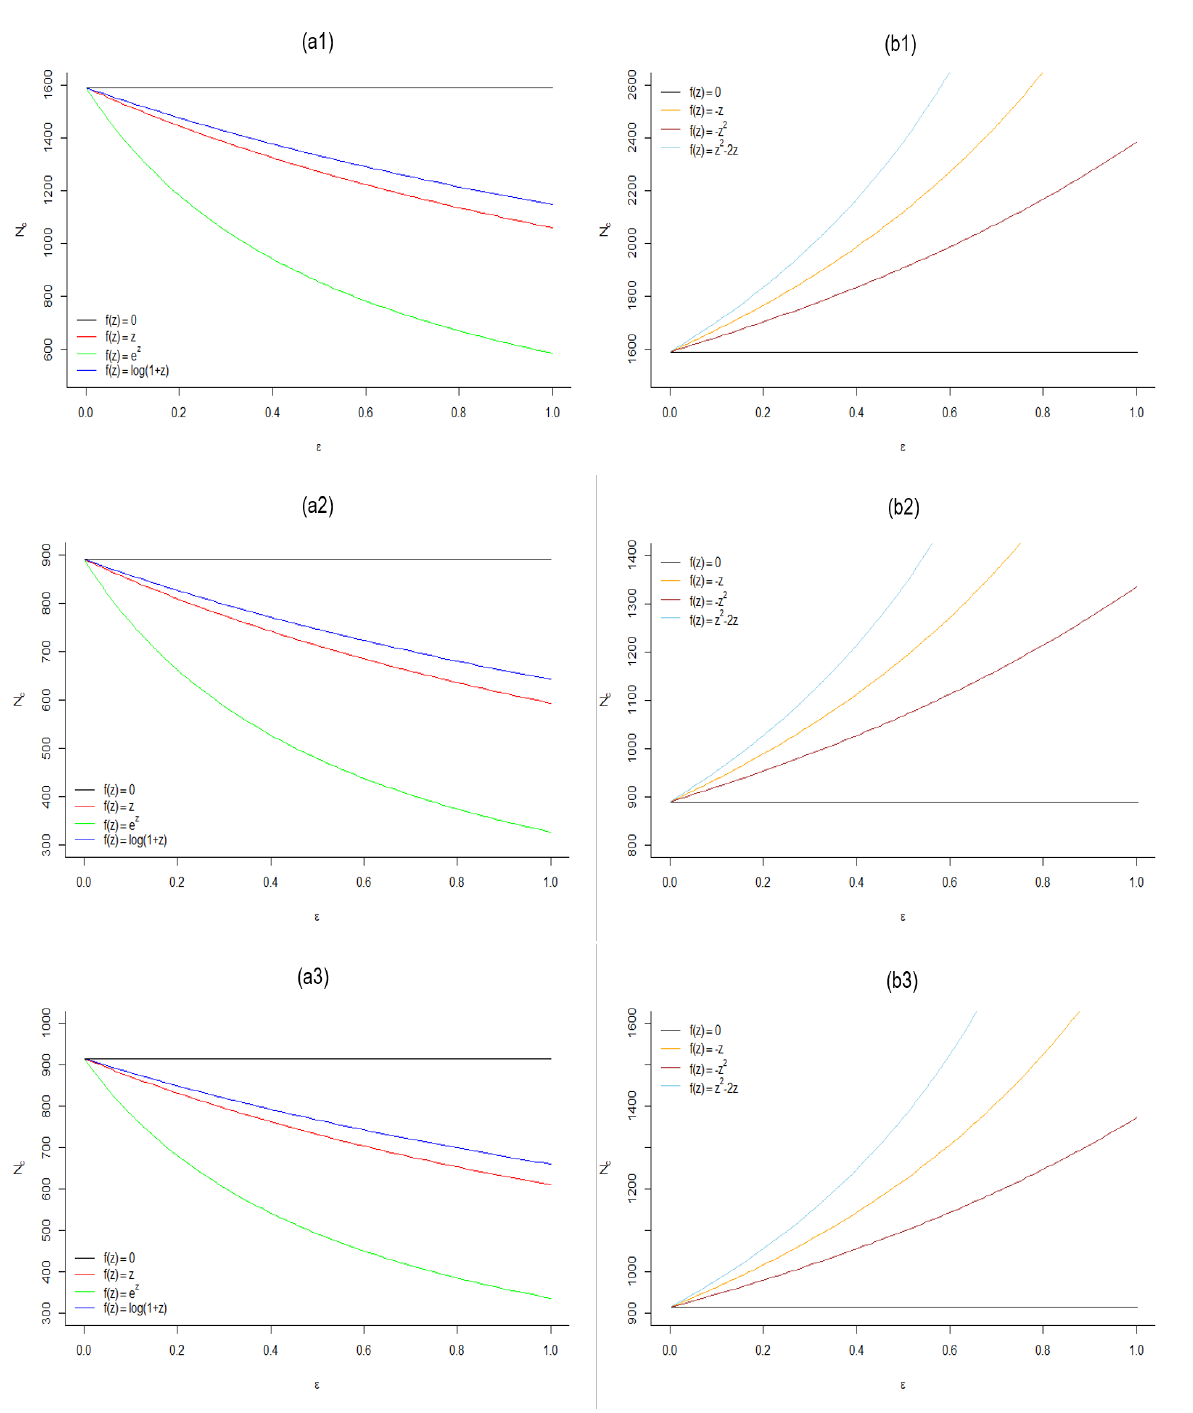
Figure 4. For different changeable gravity functions, relationship between N c and (cid:101) , for δ = 0.04 and M 3 = 1 in ( a1 , b1 ), for δ = 0.04 and M 3 = 10 in ( a2 , b2 ), for δ = 0.04 and M 3 = 20 in ( a3 , b3